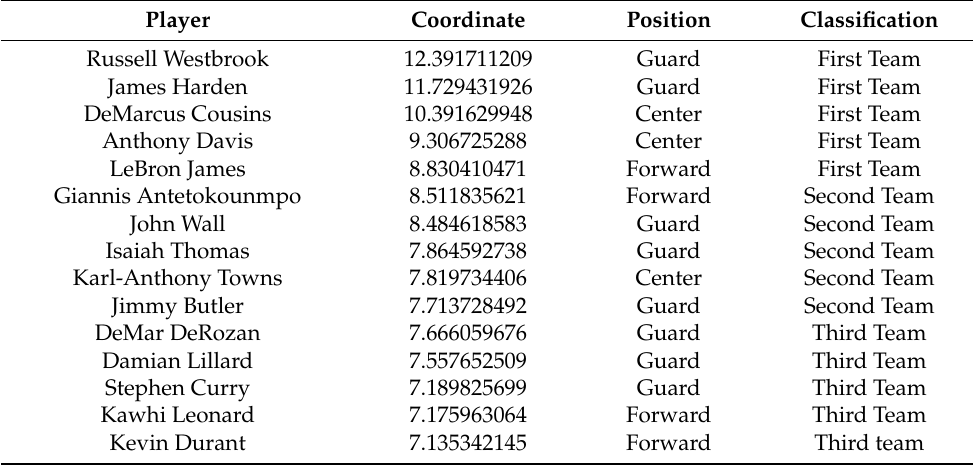
Table A4. All-NBA Teams’ selection through PC1, 2016–17 NBA Season.